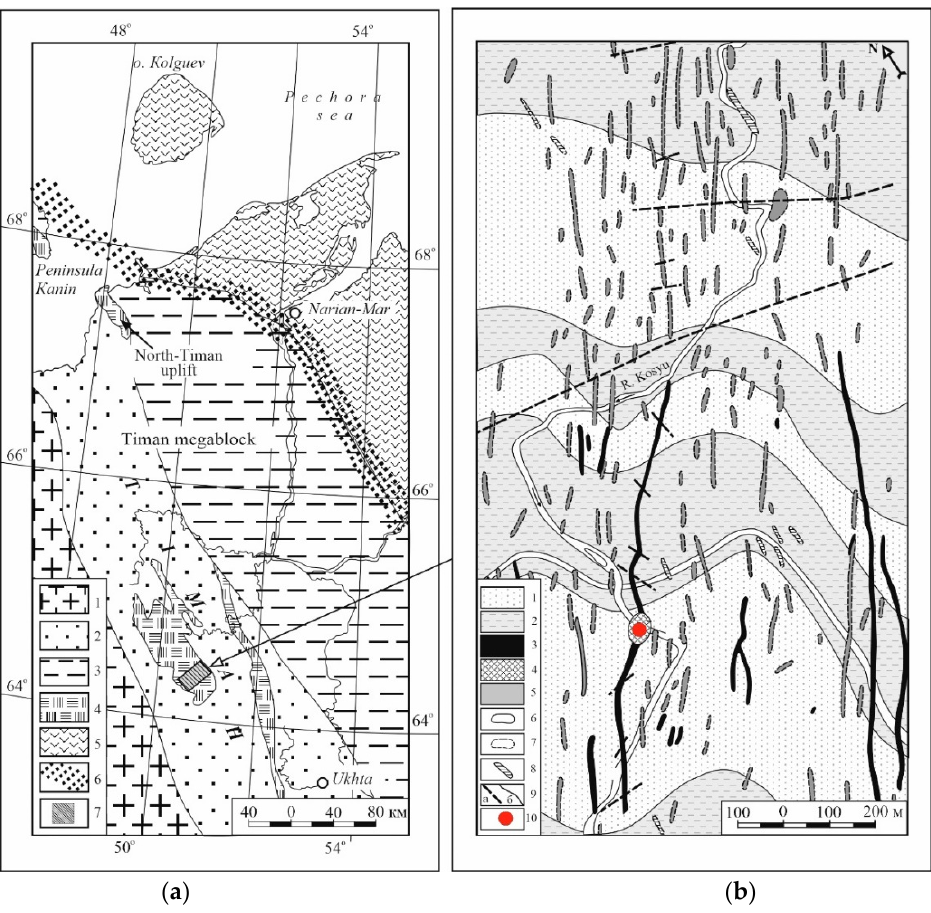
Figure 2. ( а ) Tectonic scheme of the Middle Timan (after [25]): 1—East European Craton; 2–5—basement of the Pechora plate: 2—Timan; 3—Izhemsky zone; 4—outcrops of the basement complexes; 5—Pechora zone; 6—Pripechorsko-Ilych-